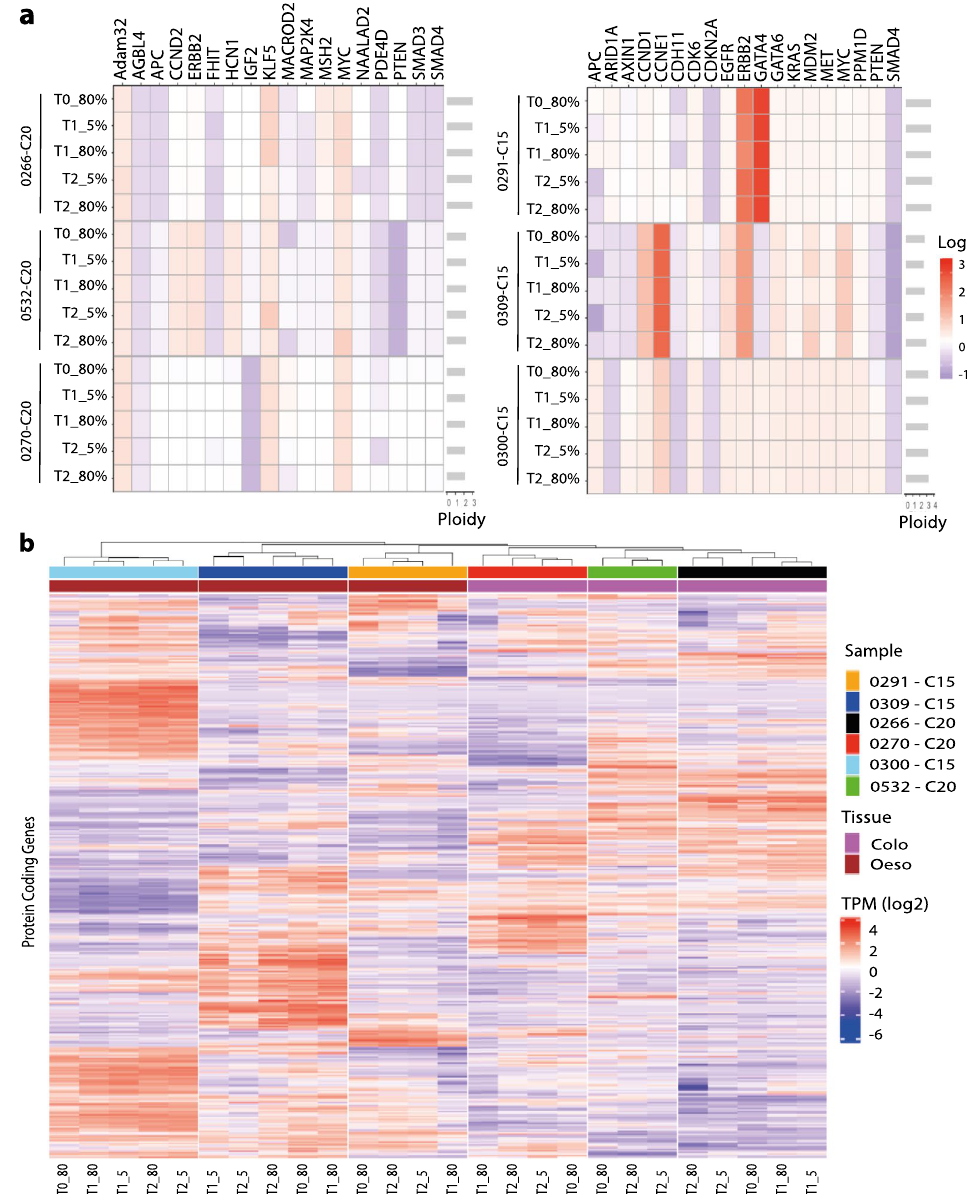
Figure 3. Copy number variation and gene expression in 5% ECM and standard 80% ECM culture conditions. ( a ) Tile plot showing the LogR values of copy number altered tissue-specific cancer driver genes. ( b ) Unsupervised hierarchical clustering of log TPM values for the 3000 most differentially expressed genes. The colour scale shows square root of standardised log 2 TPM values scaled by the standard deviation and centred to the mean. The timepoint (T0, T1 or T2) and culture conditions (5 or 80% ECM) are shown for each organoid